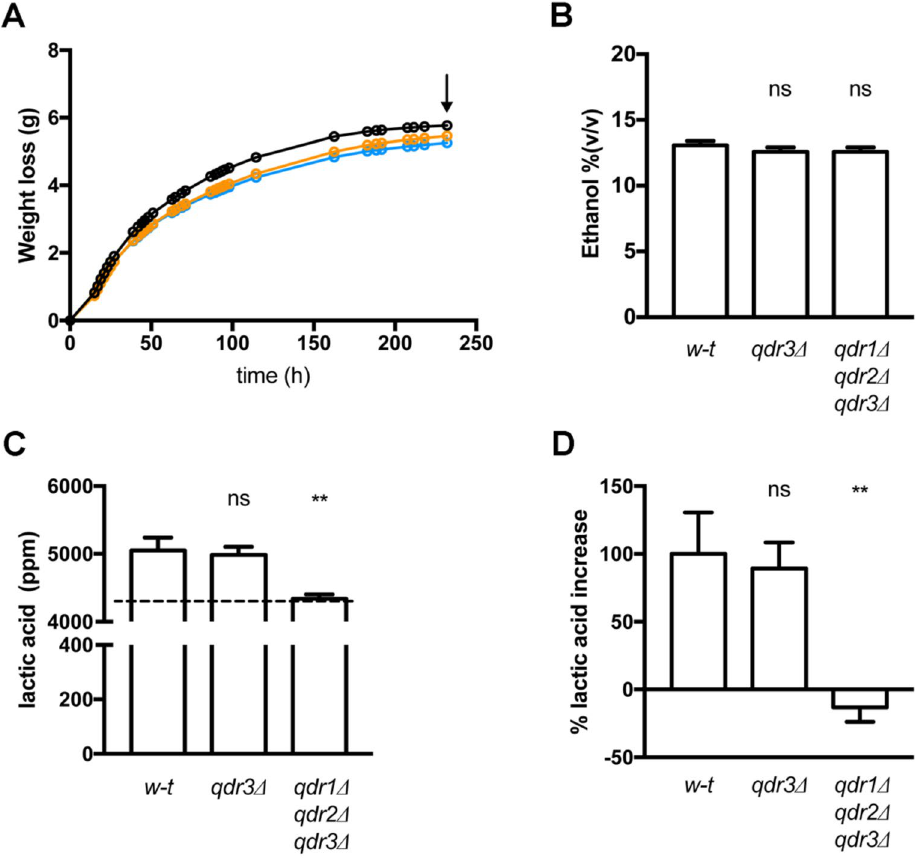
Figure 3. Loss of Qdr amino acid exporters in the Ethanol Red strain prevents a lactic acid increase during growth on molasses. ( A ) Wild-type (black) , qdr3Δ (orange), and qdr1Δ qdr2Δ qdr3Δ (blue) Ethanol Red cells were grown on nonsterile molasses-based medium and weight loss was monitored along time. Arrow show the end of each fermentation and the sampling timepoint. ( B ) Ethanol concentration in the medium at the end of each fermentation. ( C ) Lactic acid concentration at the end of each fermentation. The dotted line corresponds to the lactic acid detected in the medium before inoculation with yeast. ( D ) Concentrations of lactic acid expressed as percentages of that observed in supernatants of the wild-type cultures. Bars represent averages of three independent experiments ± standard deviation (SD). * indicates a statistically significant difference as determined with the unpaired t test. ** P < 0.0021; ns: not significant, P >